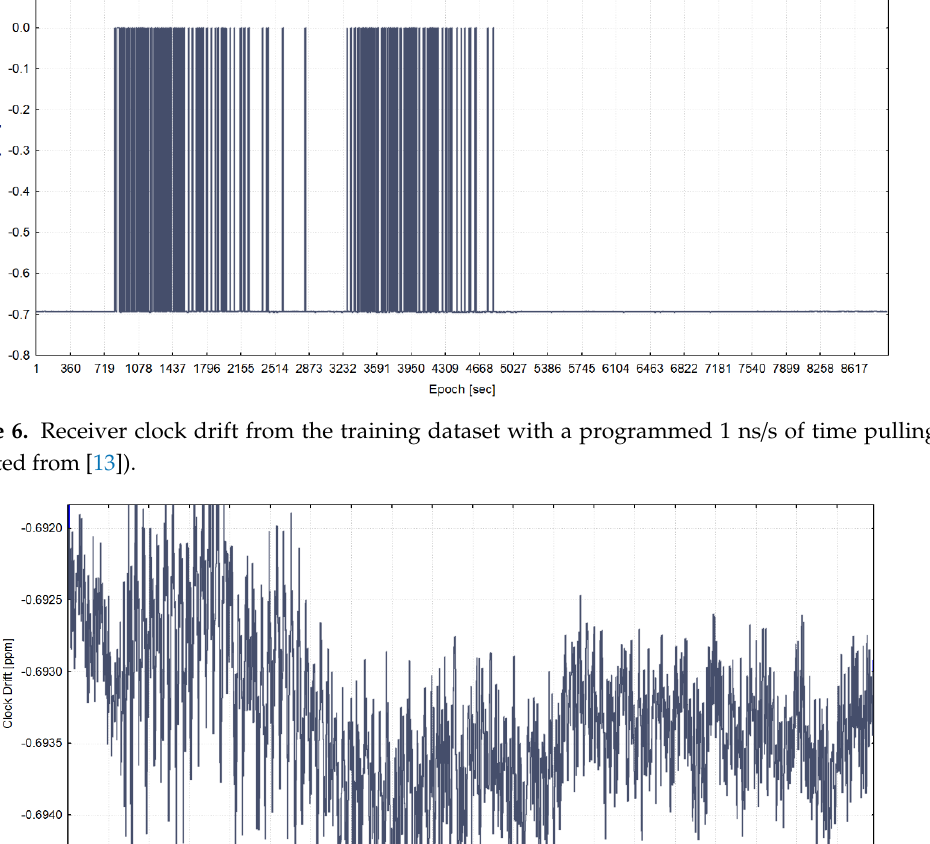
(adapted from [13]). Sensors 2019 , 19 , x FOR PEER REVIEW